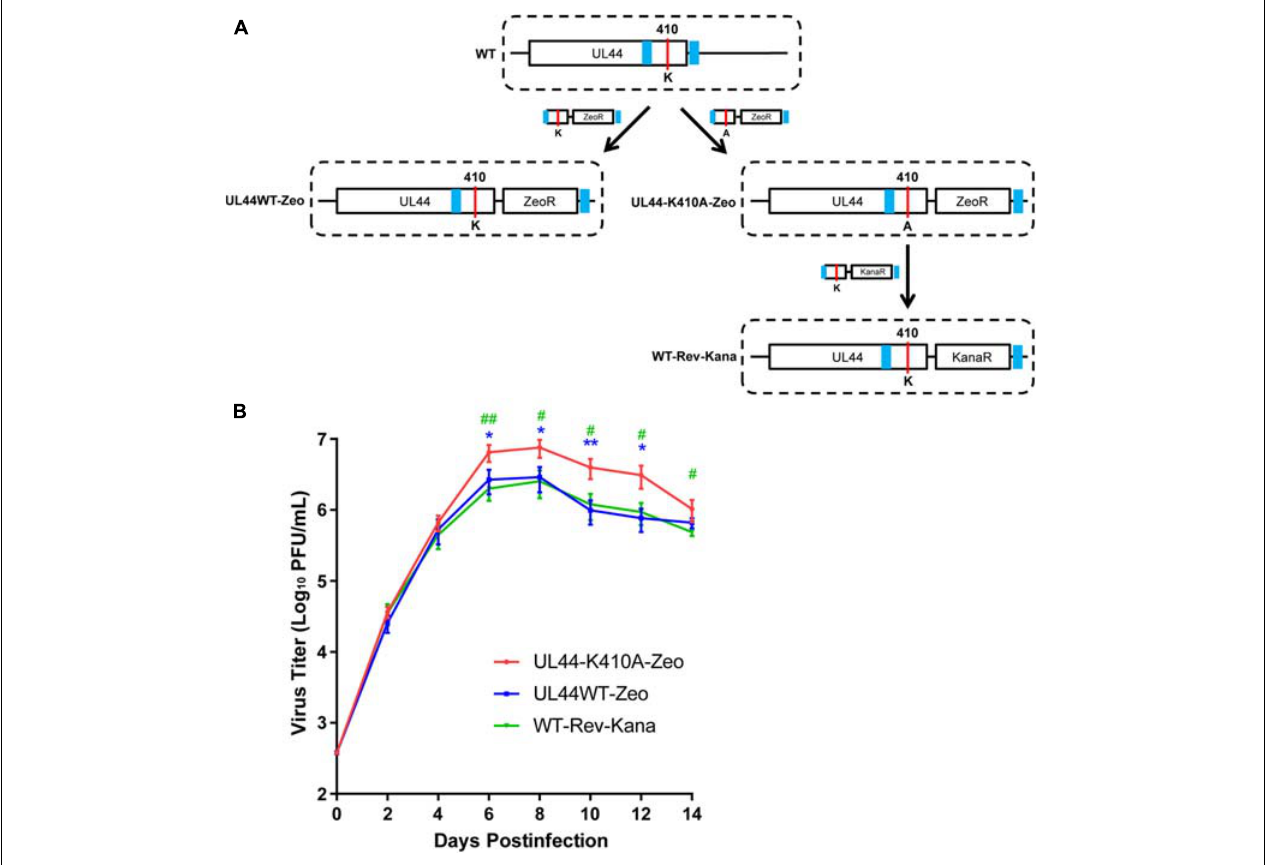
FIGURE 7 | Mutation of 410 lysine enhanced the viral replication of HCMV in HFFs. (A) Schematic for BAC construction and generation of wild-type, mutant and revertant HCMV virus. (B) The replication and spread abilities of HCMV were determined by multi-step virus growth curves. HFF cells were infected by appropriate virus (UL44WT-Zeo, UL44-K410A-Zeo, and WT-Rev-Kana) at a moi of 0.1 and collected at the indicated time points. Released virus at each time point was titrated on HFFs by serial dilutions and plaques counting to generate growth curves. Titration of each time point was done in triplicate and titer values were means from triplicate experiments. Error bars = SD. Differences among three viruses at each time point were assessed by One-way ANOVA with Tukey’s post hoc test. * denotes p < 0.05, and ** denotes p < 0.01 by One-way ANOVA with Tukey’s multiple comparison test with UL44WT-Zeo. # denotes p < 0.05, and ## denotes p < 0.01 by One-way ANOVA with Tukey’s multiple comparison test with